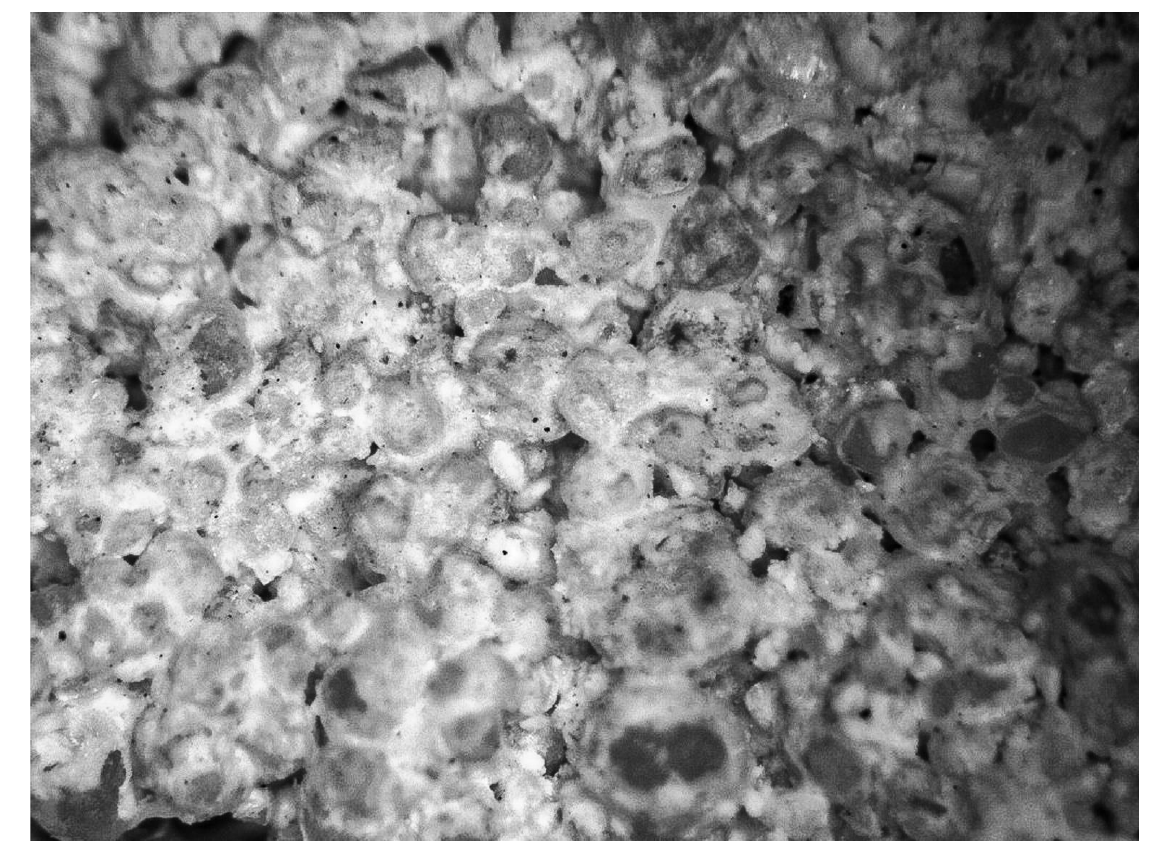
Figure 12. Optical microscope photo of the BP10-W10 sample.